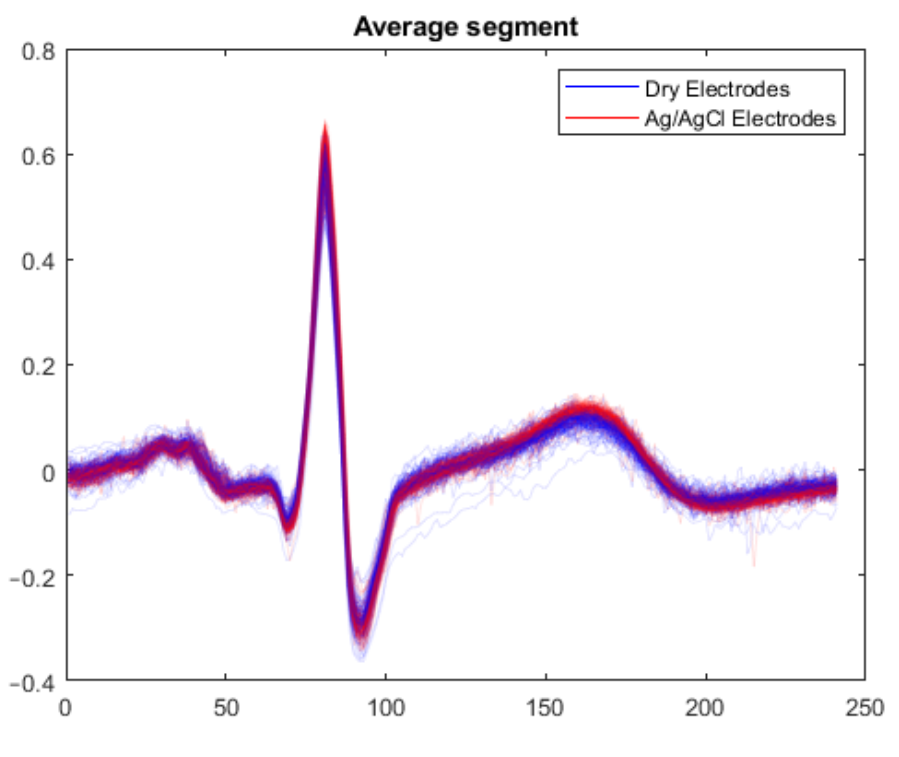
Figure 6. Beat-by-beat